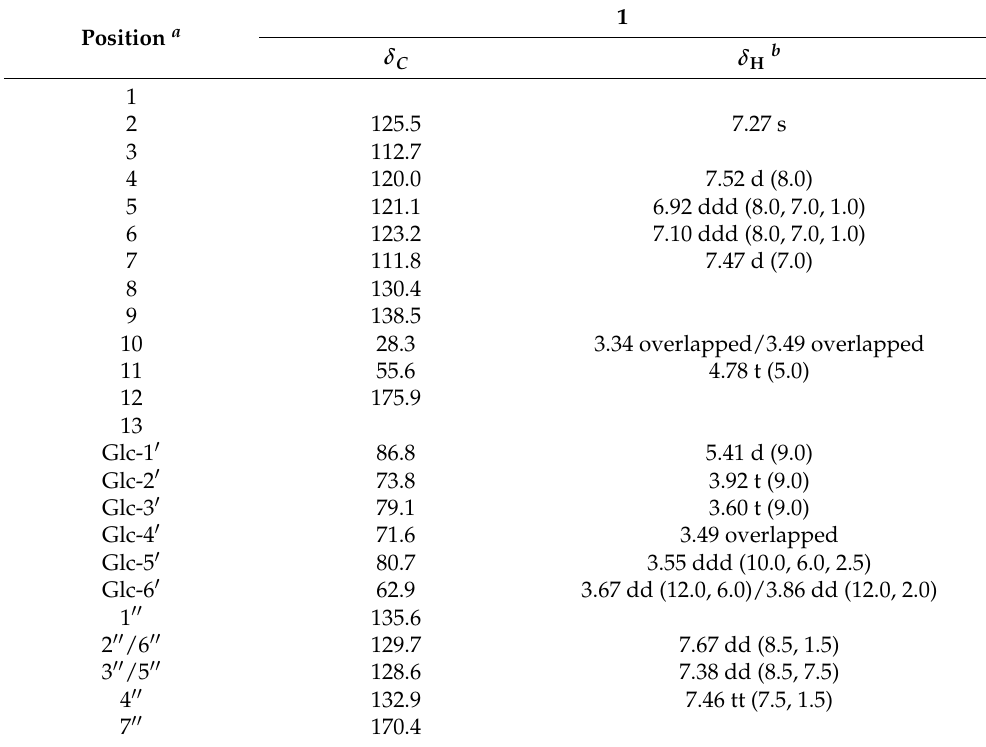
Table 1. 1 H- and 13 C-NMR spectroscopic data of compound 1 ( δ in ppm, methanol- d 4 , 500 MHz, and 125